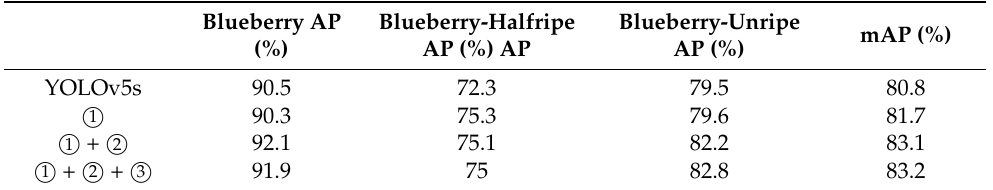
Table 6. Experimental results after different modules being added ( 1 (cid:13) represents NCBAM, 2 (cid:13) represents Small object detection layer, and 3 (cid:13) represents C3Ghost).